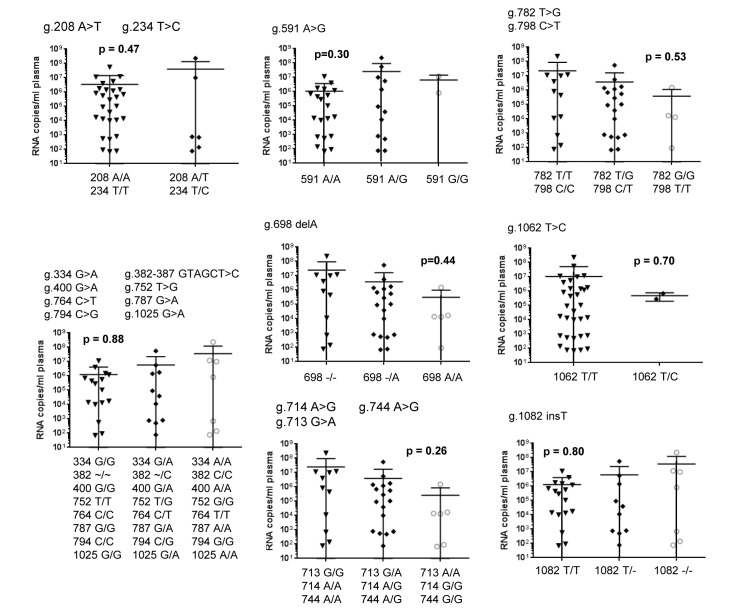
rhIFITM3(2) alleles and viral load at set point in SIV-infected rhesus macaques.For each polymorphism, the virus load at set point (20 weeks post infection) was compared between different genotypes. The polymorphisms are indicated above each diagram together with the p-values obtained by a Mann-Whitney or a Kruskal-Wallis test. Individual genotypes are noted below each diagram. Virus load is shown as RNA copies/mL plasma.